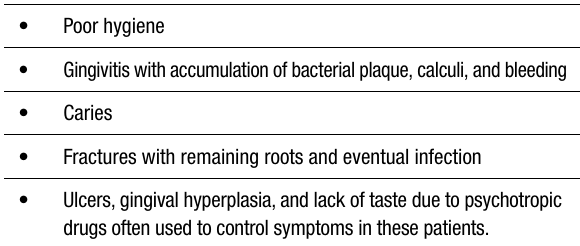
Table 5. The main changes seen in the oral cavity of patients with dementia are: